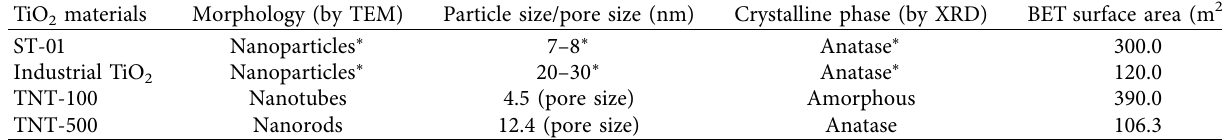
Table 1: Properties of TiO 2 materials used in the photocatalysis experiments.